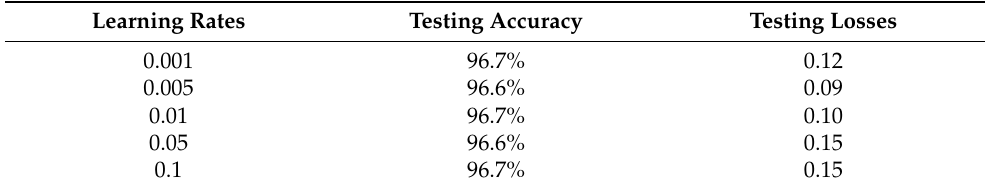
Table 5. Testing accuracy and testing losses for multiple learning rates values.